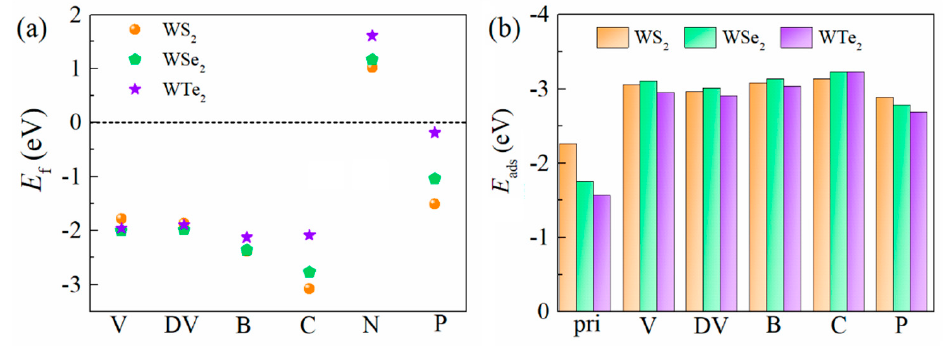
Figure 2. ( a ) Defect formation energy of the single − vacancy (V), double − vacancy (DV), and light element substitution for the different materials, including the T’ − WS 2 , T’ − WSe 2 , and T’ − WTe 2 mon- olayers. ( b ) Adsorption energy of H with the different defect structures in the most stable configu- rations.